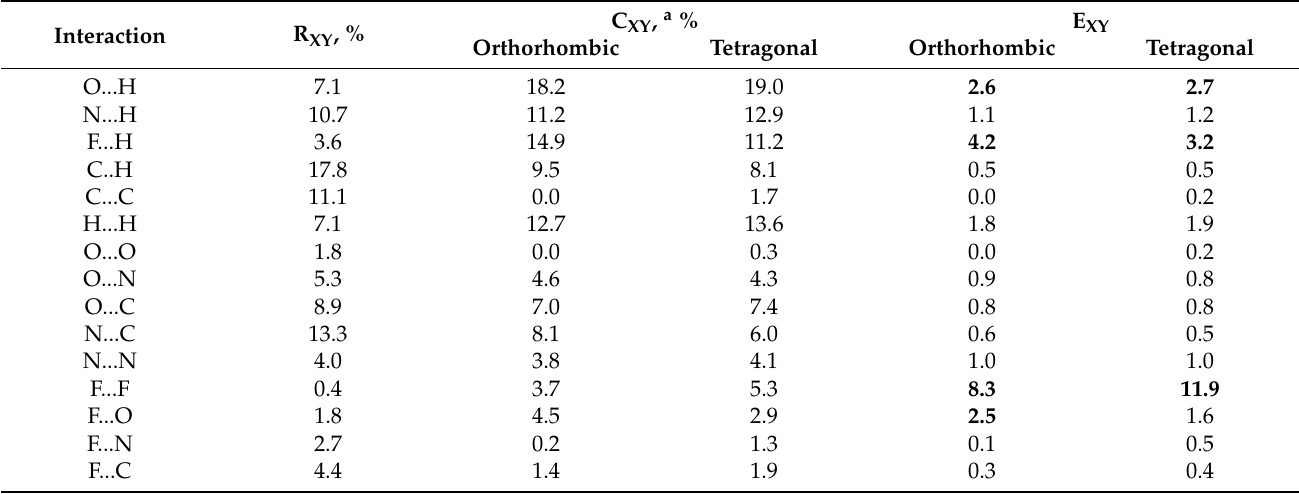
Table 4. Contributions C XY of various types of intermolecular interactions to the molecular Hirshfeld surface of two polymorphs, their R XY values and enrichment ratios E XY . Interaction